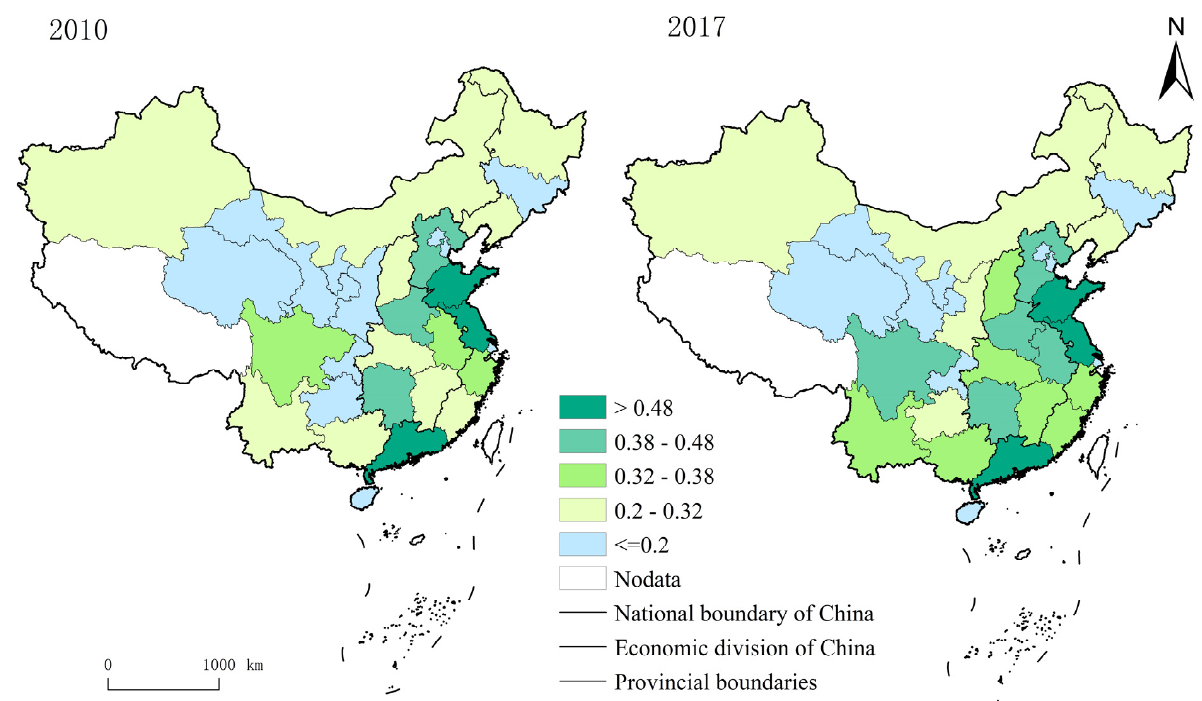
Figure 4. Spatial distribution of ecosystem service demand in China from 2010 to 2017.